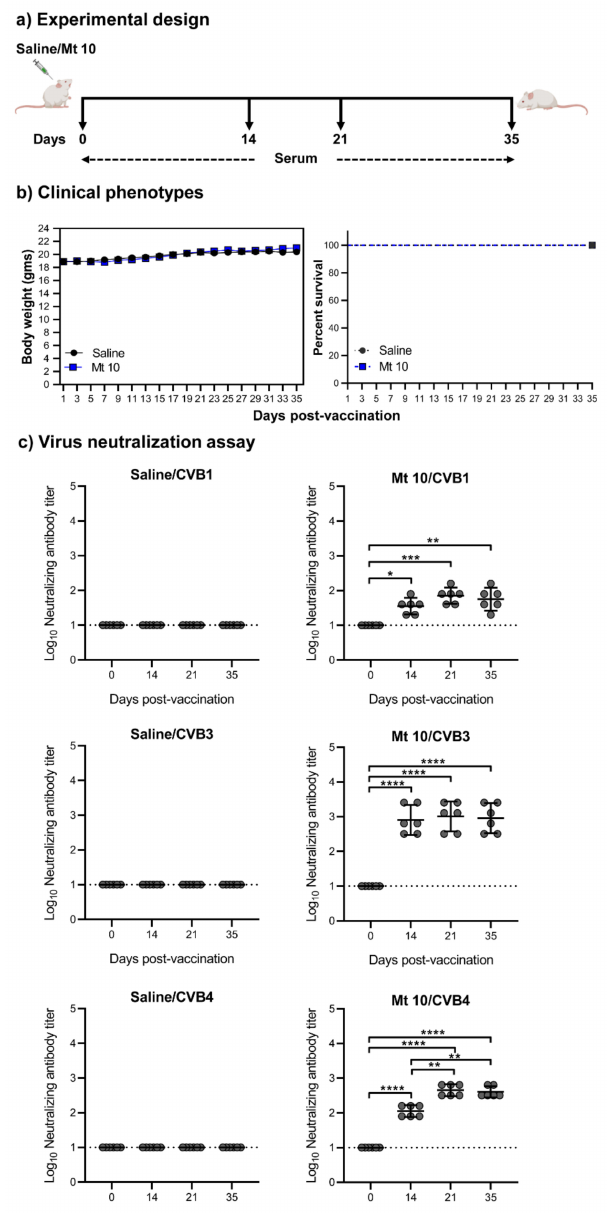
Figure 1. Vaccine virus produces nABs against multiple CVB serotypes. ( a ) Experimental design. A/J mice were vaccinated with Mt10 virus (n = 18); saline recipients served as controls (n = 15). Sera were collected on days 0, 14, 21, and 35 post-vaccination and terminated on day 35. ( b ) Clinical phenotypes. Body weights were measured once every two days until termination and compared between groups (left panel), and survival rates were tabulated (right panel). ( c ) Virus neutralization assay. Sera were obtained from saline and vaccine recipients on days 0, 14, 21, and 35, serial dilutions up to 1:20,480 were made, and samples were incubated with CVB1 (top panel), CVB3 (middle panel), or CVB4 (bottom panel). The mixtures were later transferred to plates containing monolayers of LLC-MK2 cells for CVB1 or Vero cells for CVB3 and CVB4 and incubated for four days to calculate the percentage neutralization based on CPE caused by the viruses. Data from n = 6 samples, each representing a pool of sera from 3 to 5 mice, are shown. Two-way ANOVA with a Sidak’s post-test was used to compare nABs and body weight changes in the saline group relative to the vaccine- recipient group; log-rank test with Bonferroni correction was used to compare survival curves. * p ≤ 0.05, ** p ≤ 0.01, *** p ≤ 0.001, and **** p ≤